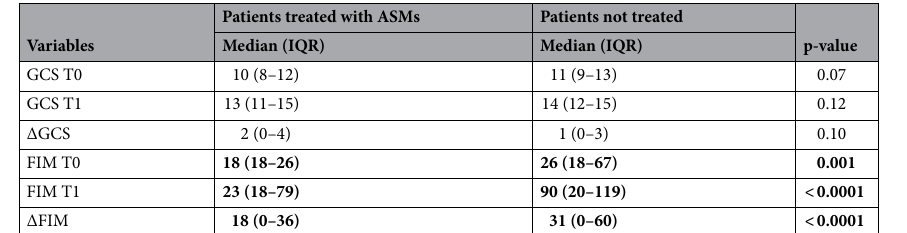
Patients treated with